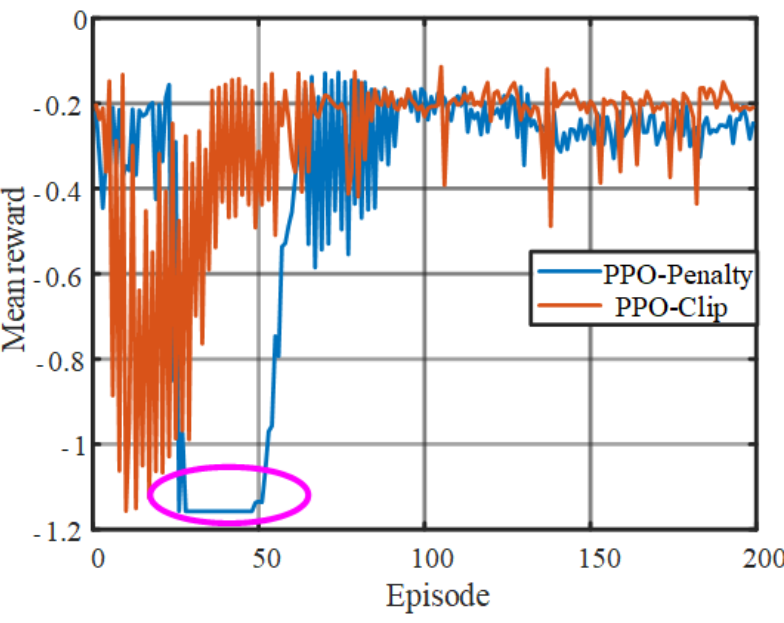
Figure 10. The mean rewards of the PPO-based EMSs.